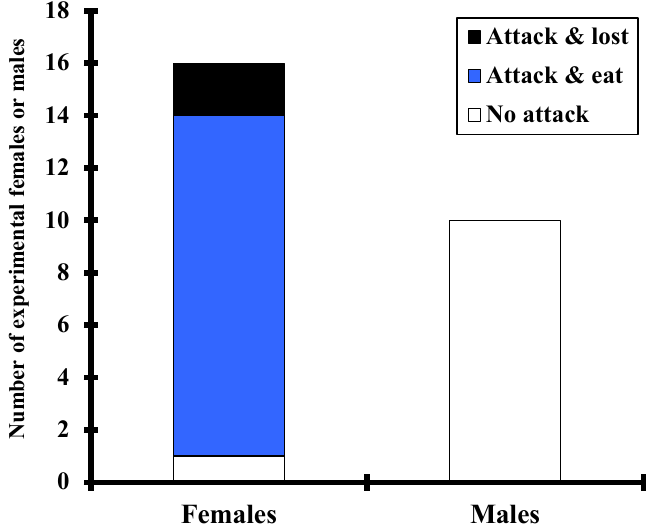
Figure 1. Number of experimental, field-collected Photuris lugubris females and males that did not attack, attack-and-ate or attack-and-lost the male Photinus palaciosi introduced to their containers.